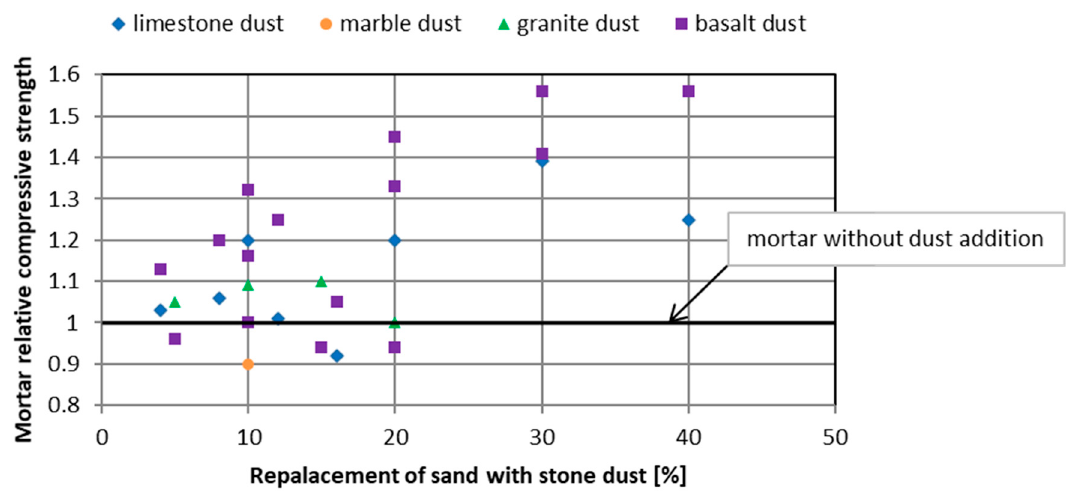
Figure 1. The influence of rock dust on the compressive strength of cement mortars after 28 days of hardening [14,21,24,27,28].